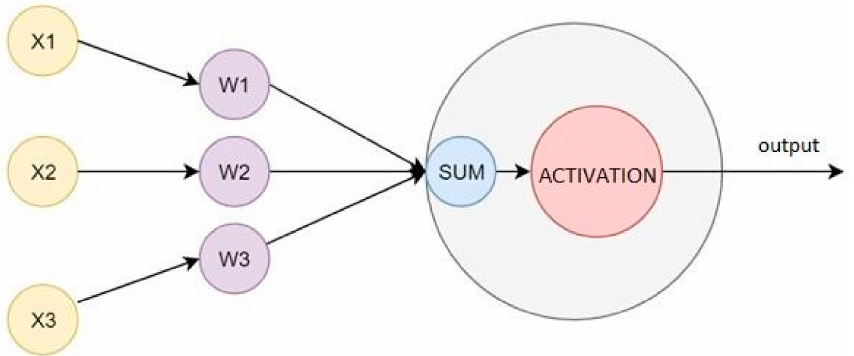
Figure 1. Perceptron—A neuron’s mathematical model [83], based on our own editing. Legend: (X1, X2, X3) Input, (W1, W2, W3) Weight.